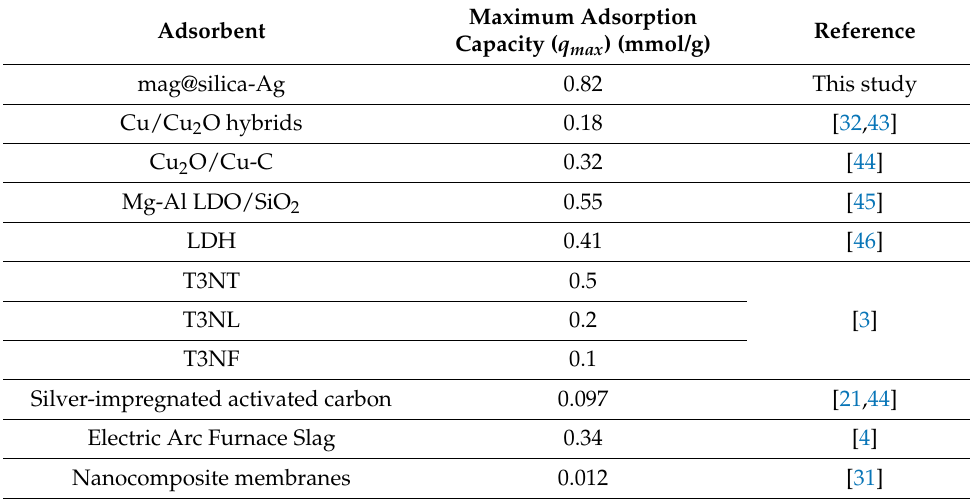
Table 5. Comparison of maximum adsorption capacity with previously developed materials and